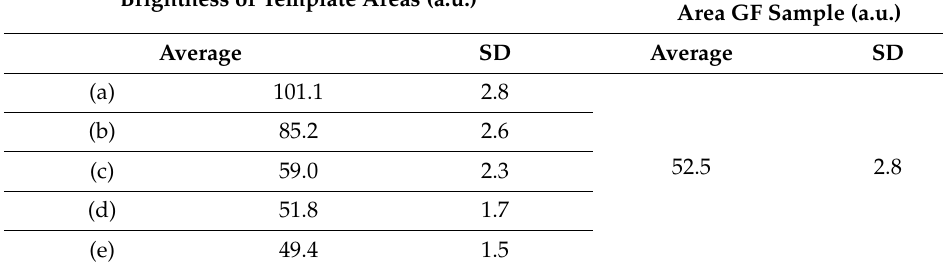
Brightness of the Corresponding Area GF Sample (a.u.)